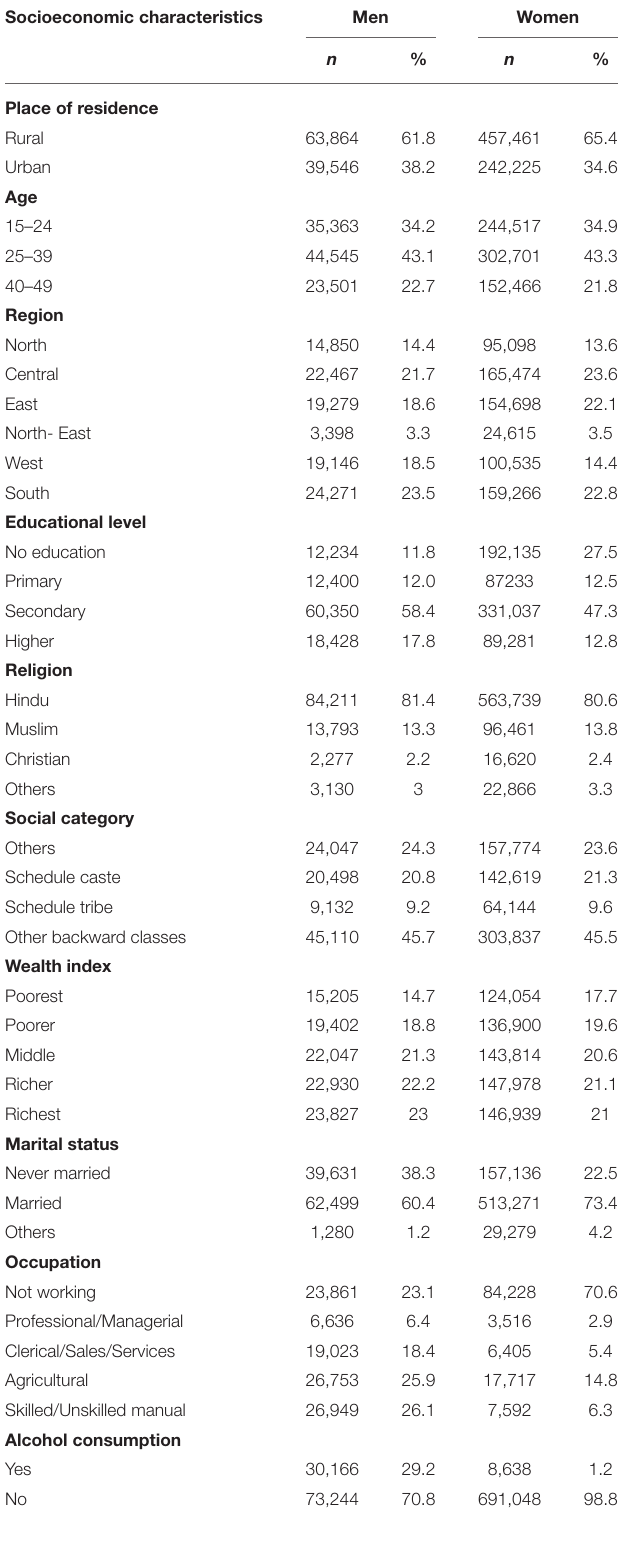
TABLE 1 | Frequency and percentage distribution of men and women responders (15–49 years) by sociodemographic characteristics, National Family Health Survey (NFHS) − 4